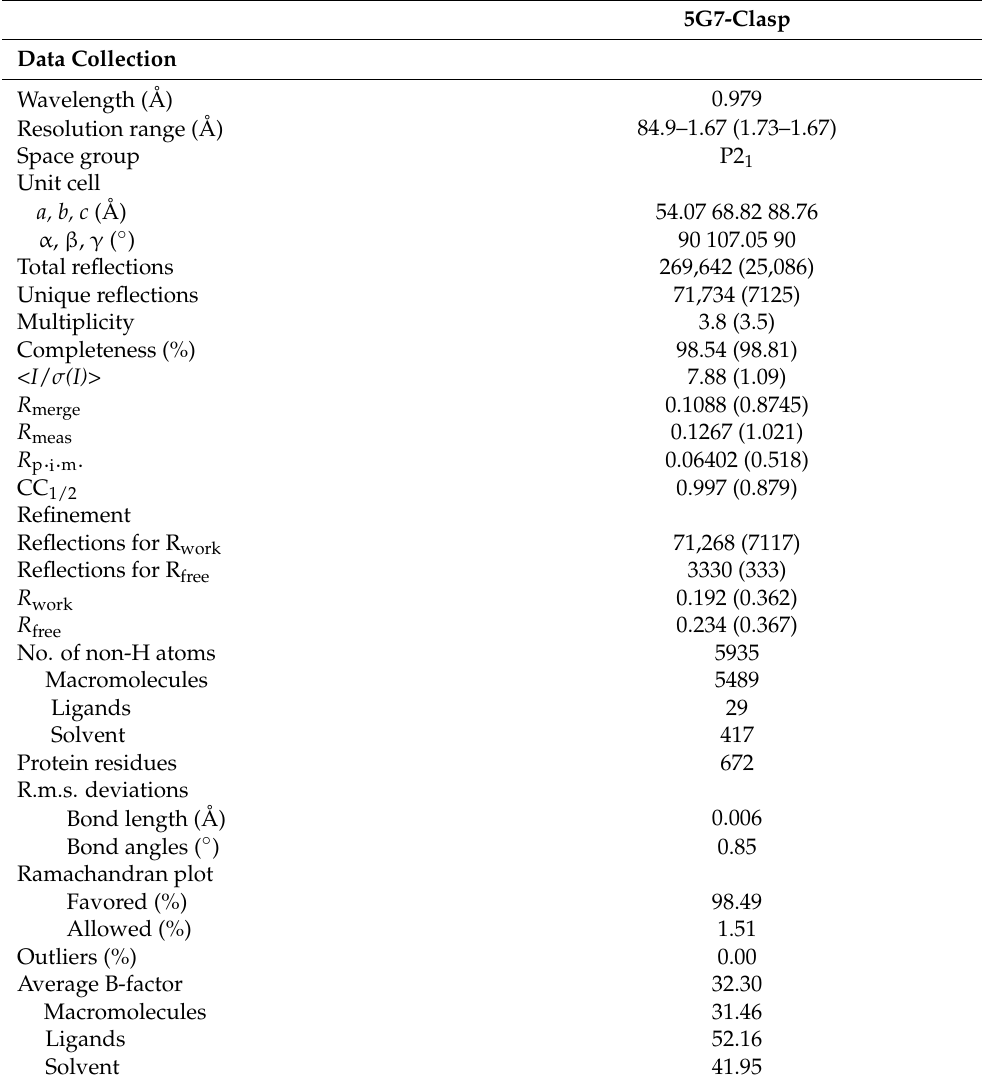
Table 1. Summary of X-ray data collection and model refinement